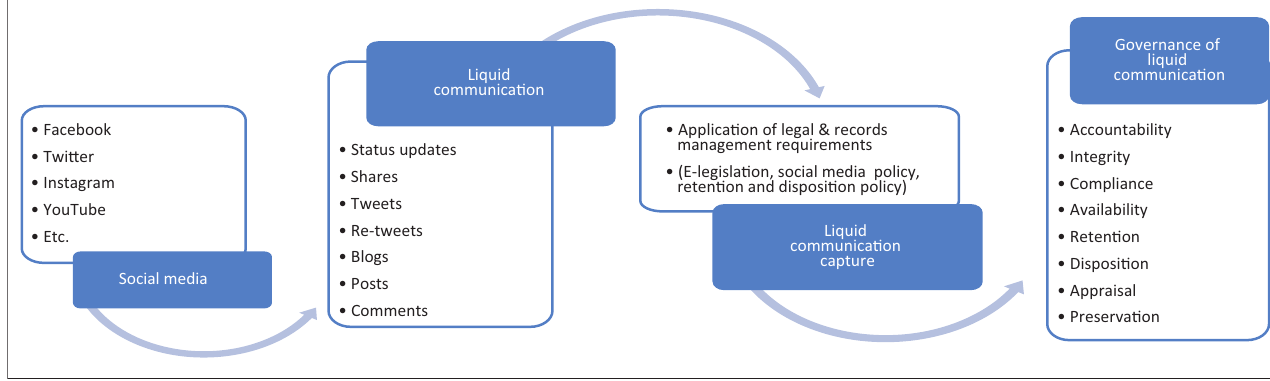
FIGURE 1: Framework for the governance of liquid communication generated through social